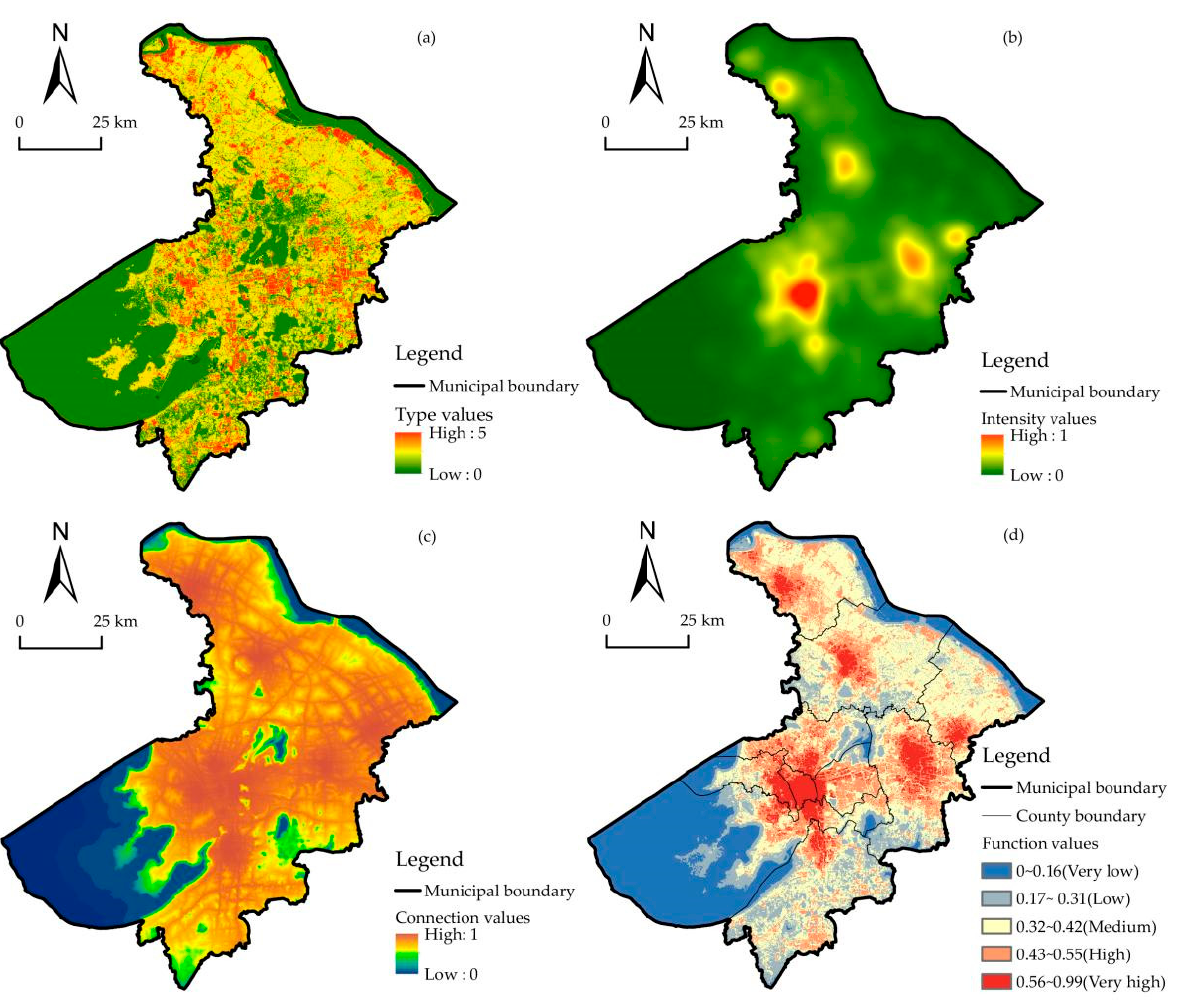
Figure 3. Functional level of production space: ( a ) Spatial type; ( b ) Spatial intensity; ( c ) Spatial connection; ( d ) Spatial function.